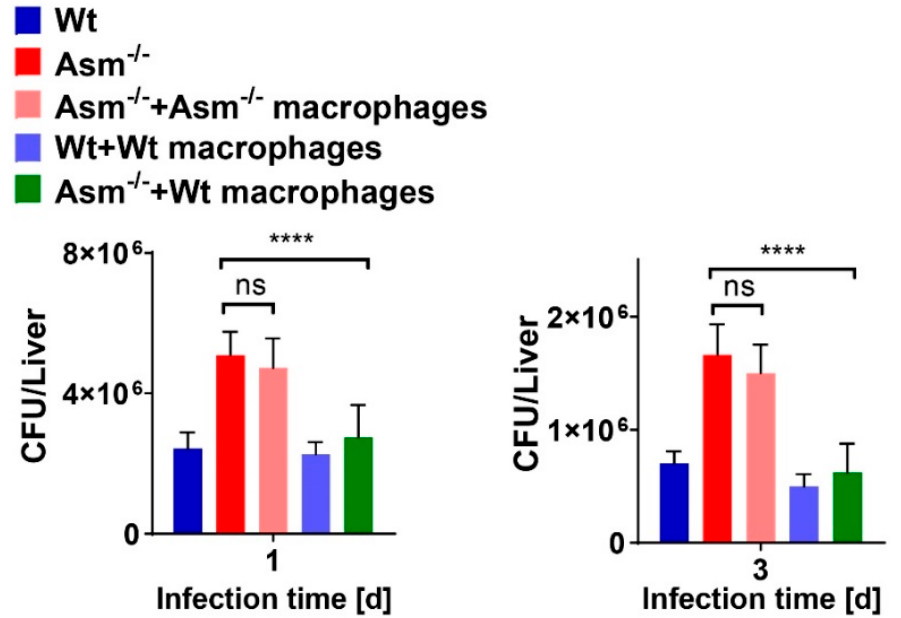
Figure 7. Transplantation of wild-type macrophages reverses susceptibility of acid-sphingomyelinase- deficient mice to BCG infection. Wild-type (wt) and acid-sphingomyelinase-deficient (Asm − / − ) mice were intravenously injected with clodronate liposomes 2 days before infection and transplanted with 5 × 10 6 wt or Asm − / − bone-marrow-derived macrophages (BMDMs) via IV injection 1 day before infection with BCG. Transplanted or control mice were infected with 10 7 BCG for 1 or 3 days. Total number of BCG in liver homogenates was determined by colony-forming unit (CFU) assays at 1 or 3 days post infection. Shown are mean ± SD; one-way ANOVA followed by a Bonferroni’s multiple comparisons test, **** p < 0.0001. ns = no significant.